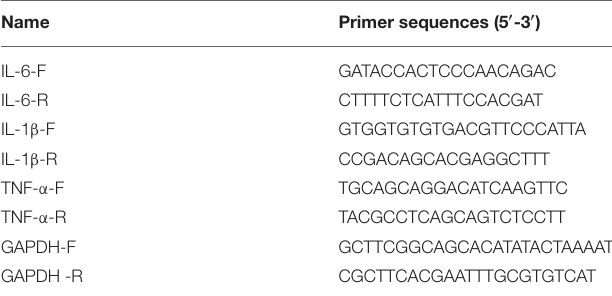
TABLE 1 | The correlative primer sequences for